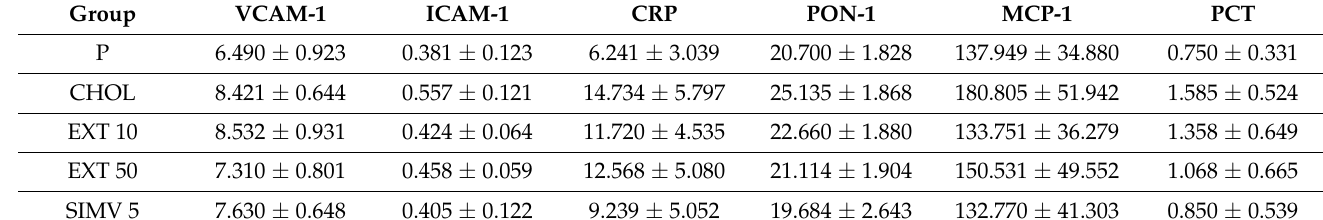
Table 2. Serum levels of VCAM-1, ICAM-1, CRP, PON-1, MCP-1, and PCT by ELISA method. Values are presented as mean ± SD. VCAM-1, ICAM-1, CRP, PON-1, and PCT concentrations are expressed as ng/mL and MCP-1 as pg/mL.